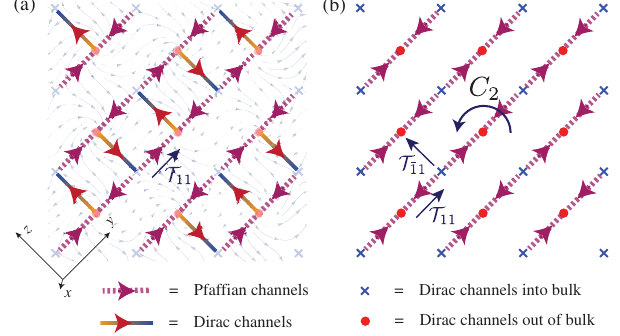
FIG. 20. Fractional surface states of (a) a 3D Dirac insulator gapped by many-body interaction that preserves T 11 , and (b) a 3D gapless interaction-enabled Dirac semimetal that preserves T T ¯11 , and C 11 , 2